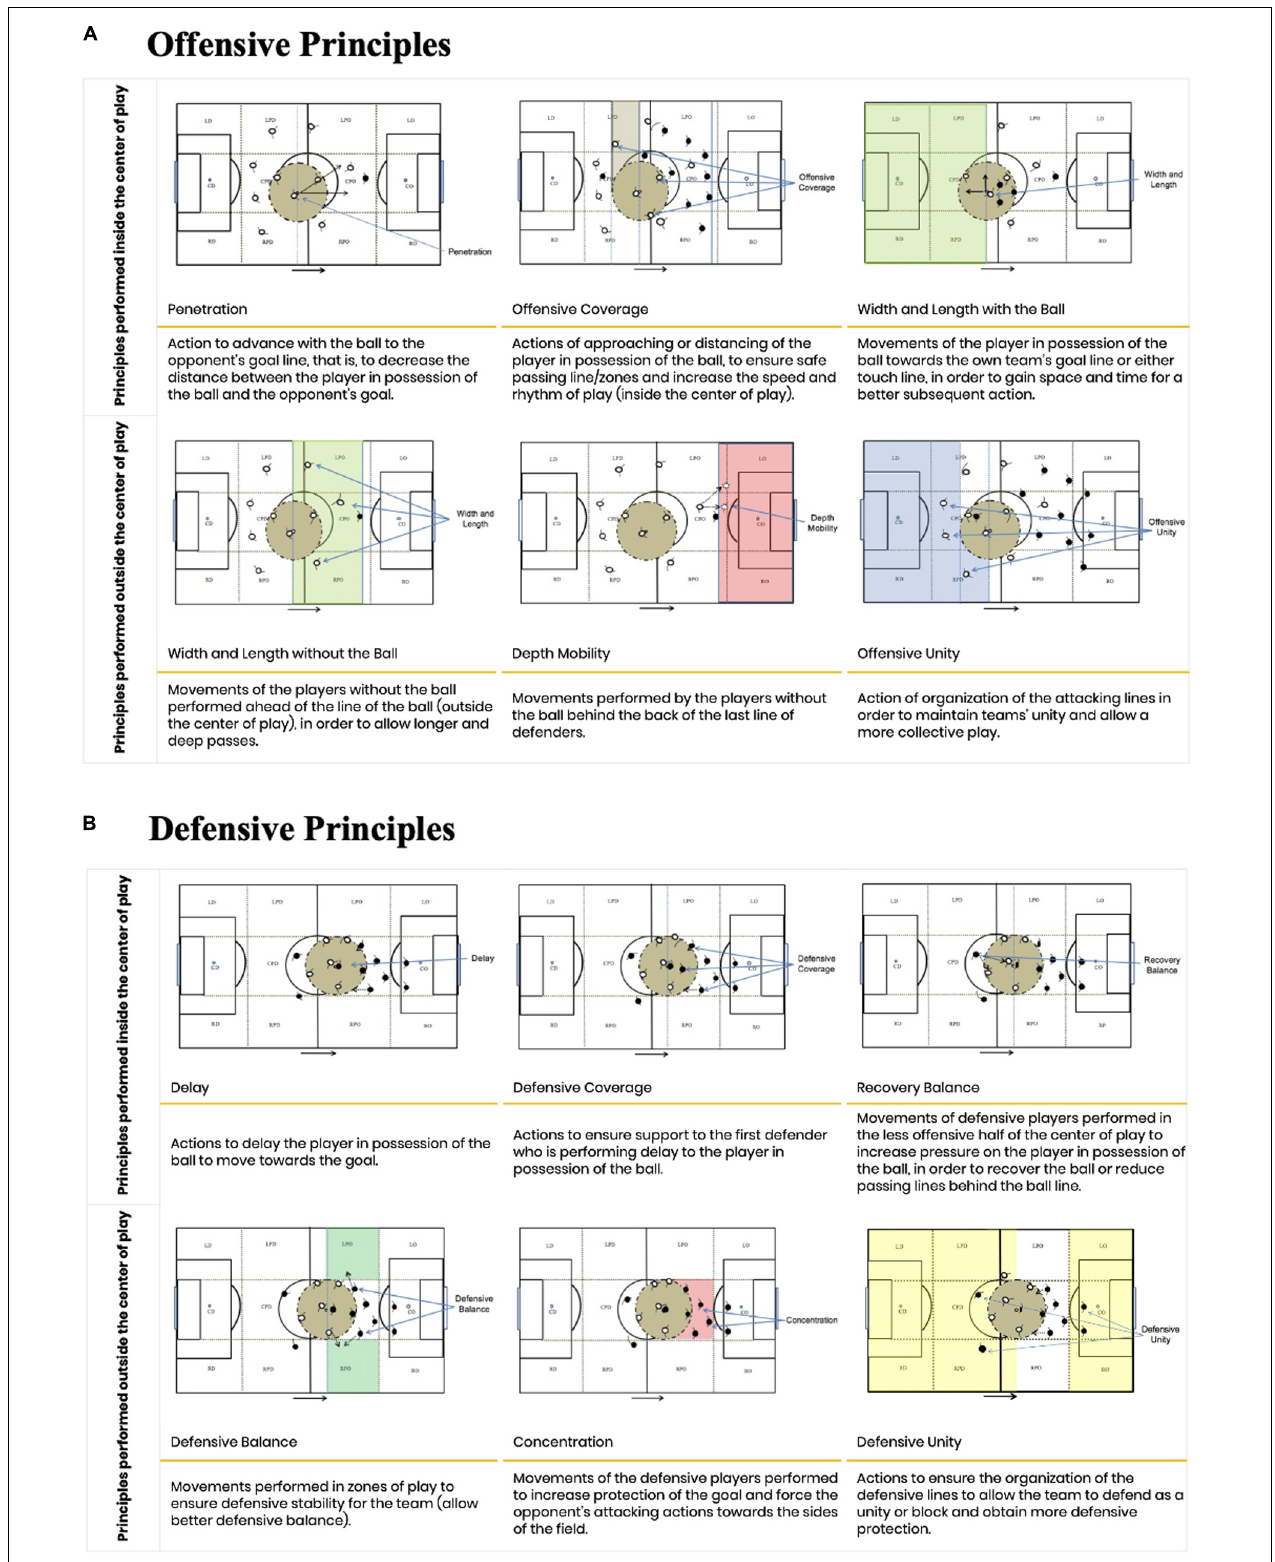
FIGURE 1 | Description of the core tactical principles of soccer: (A) offensive and (B) defensive (Source: Teoldo et al., 2017).